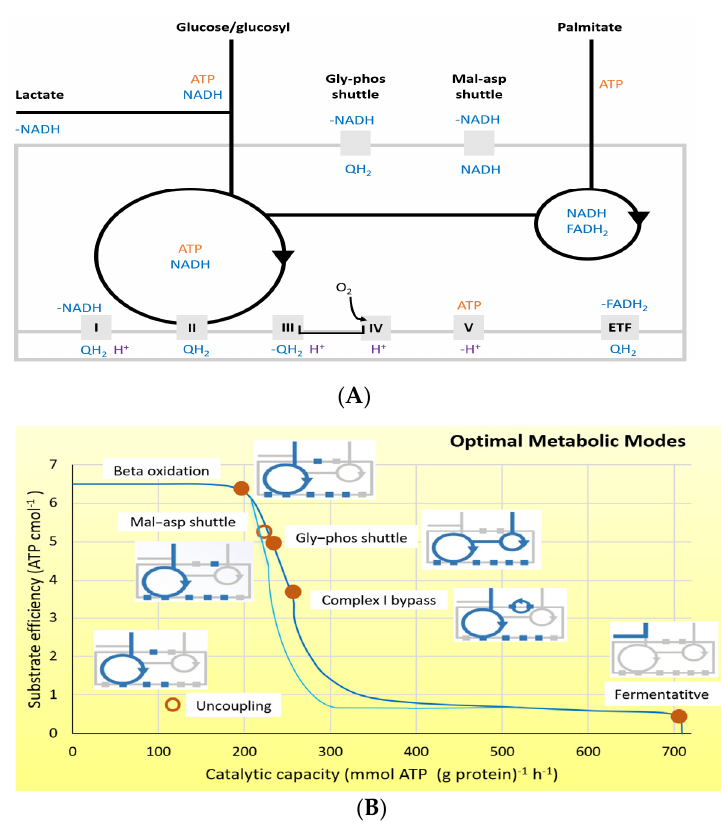
transferring flavoprotein dehydrogenase (ETF) as per the Figure 2A scheme. Complex I bypass shifts the curve right (dark blue), indicating higher substrate efficiency at high ATP synthesis/catalytic rates, relative to the alternative model (light blue).